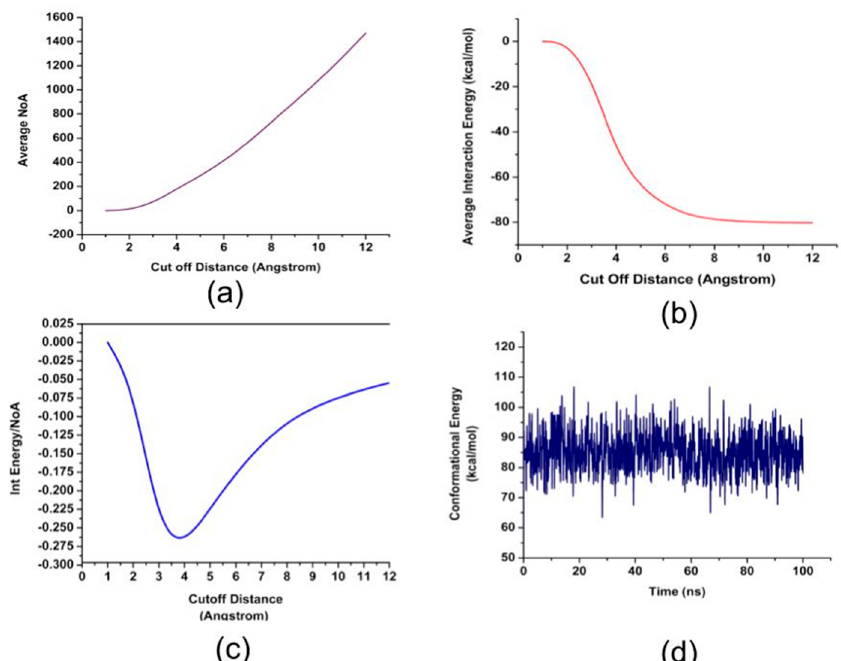
Figure 4. ( a ) The average number of atoms of the enzyme that are located from the respective cutoff distances from the graphene oxide flake; ( b ) The interaction energy between the enzyme and the graphene oxide as a function of the cutoff distance; ( c ) The interaction energy divided by the number of atoms as a function of the cut-off distance; ( d ) The conformational energies throughout the 100 ns. In order to compare the energies of binding between the 18 hydrophobic residues and the rest